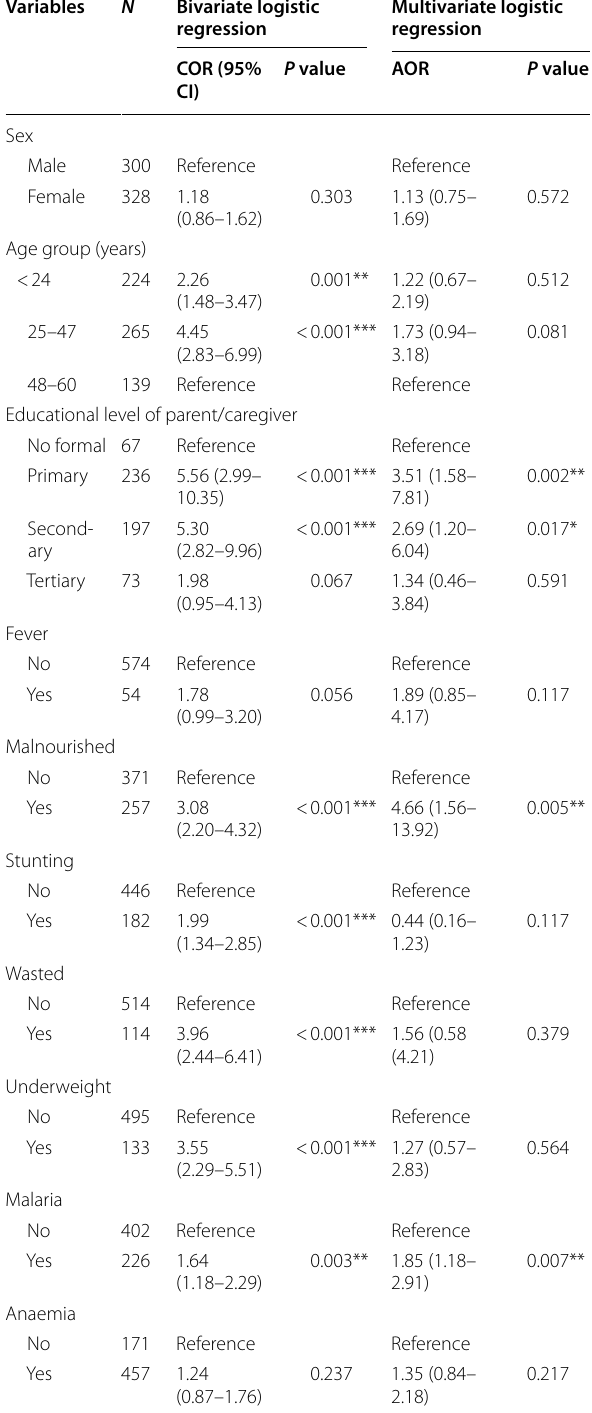
Table 5 Logistic regression model examining factors associated with anisocytosis in the study